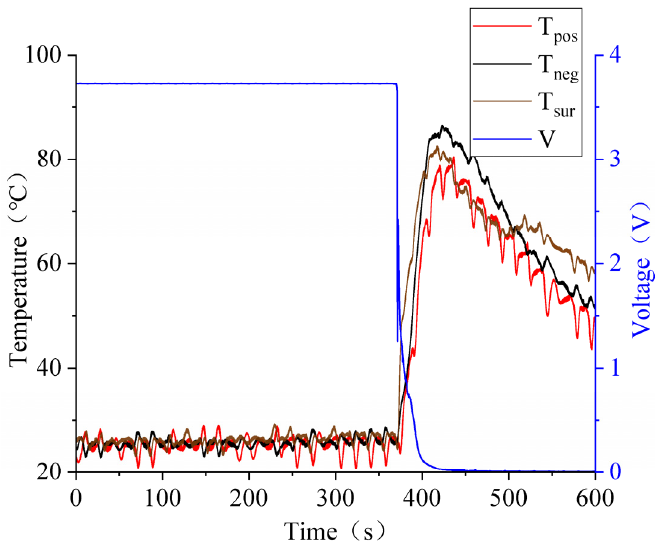
Figure 8. Twenty percent SOC state battery curve.